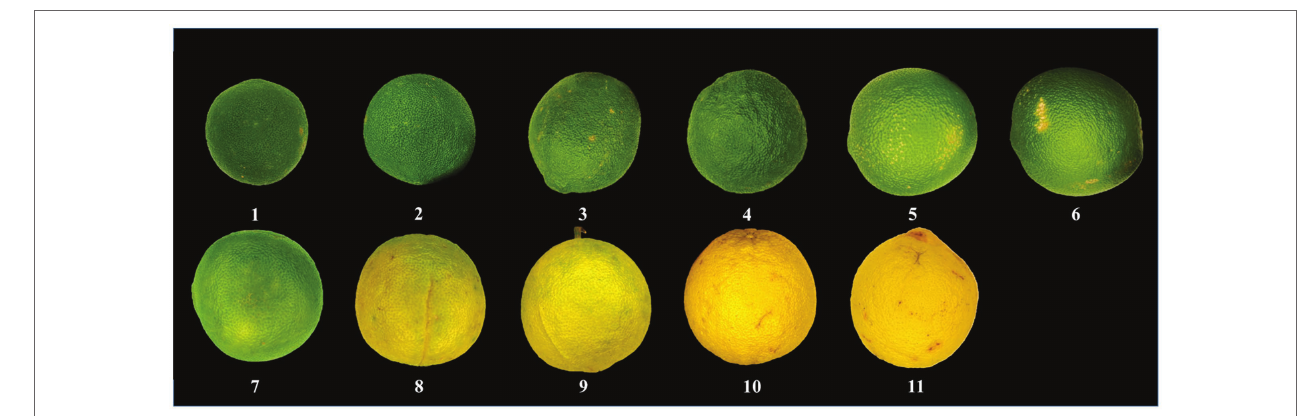
FIGURE 1 | A work-flow for this study.